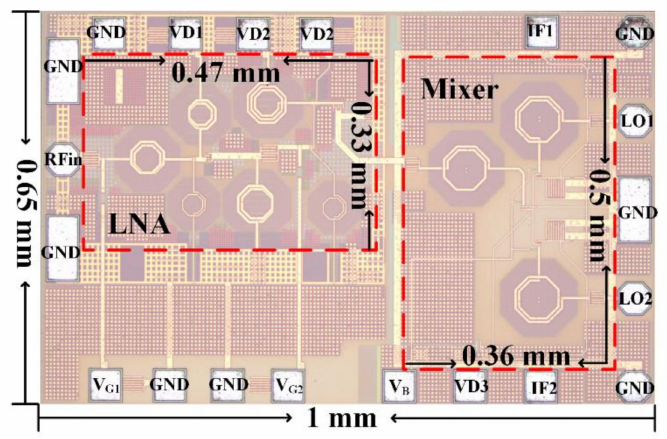
Figure 7. Chip photo of the proposed